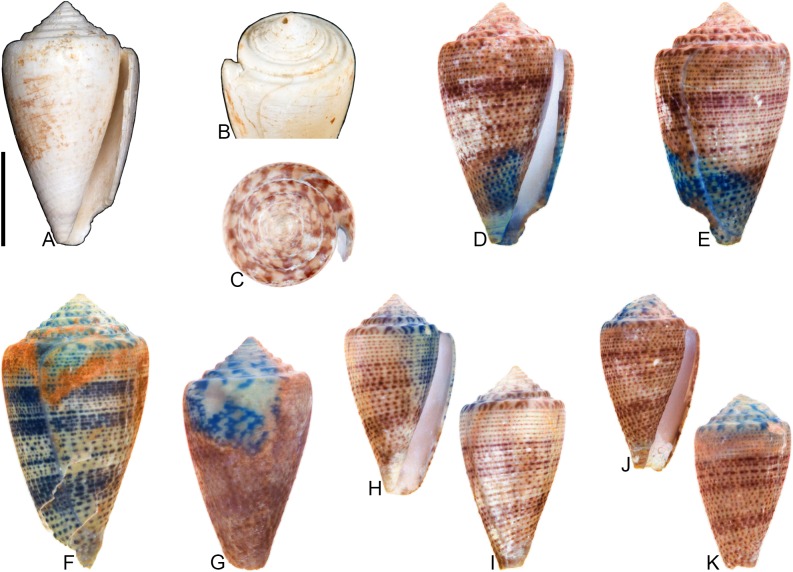

Conus (Spuriconus?) lombardii Hendricks sp. nov.All specimens are from locality station TU 1422 (Cercado Fm.). (A-E) PRI 67207 (holotype), SL 24.7 mm; (F) PRI 66165 (paratype), SL 27.4 mm; (G) PRI 67213 (paratype), SL 23.7 mm; (H-I) PRI 67218 (paratype), SL 20.5 mm; (J-K) PRI 67217 (paratype), SL 17.9 mm. (C-K) are reversed images of specimens photographed under UV light. Scale bar is 1 cm and pertains to all images.